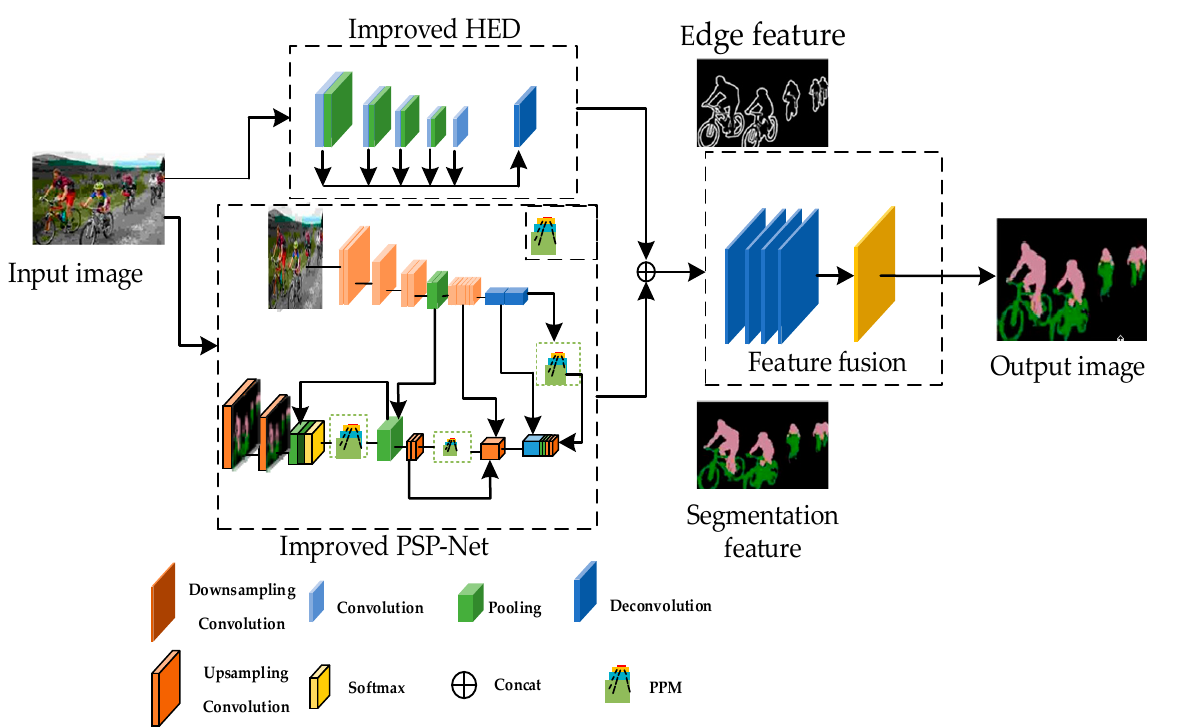
Figure 1. Improved PSP-Net combined with improved HED network.